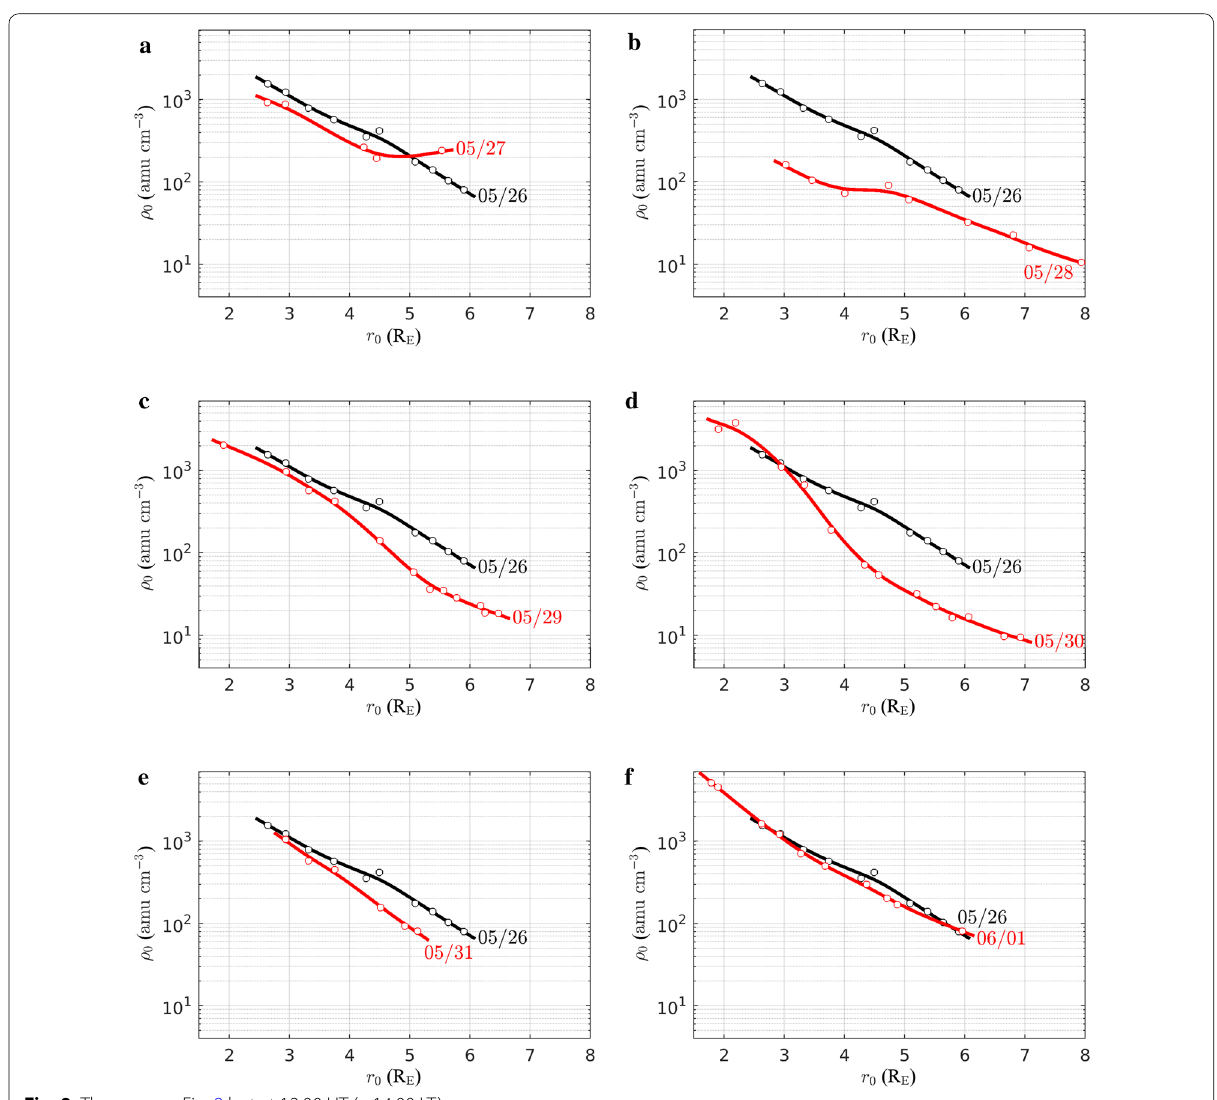
Fig. 9 The same as Fig. 8 but at 12:00 UT (~ 14:00